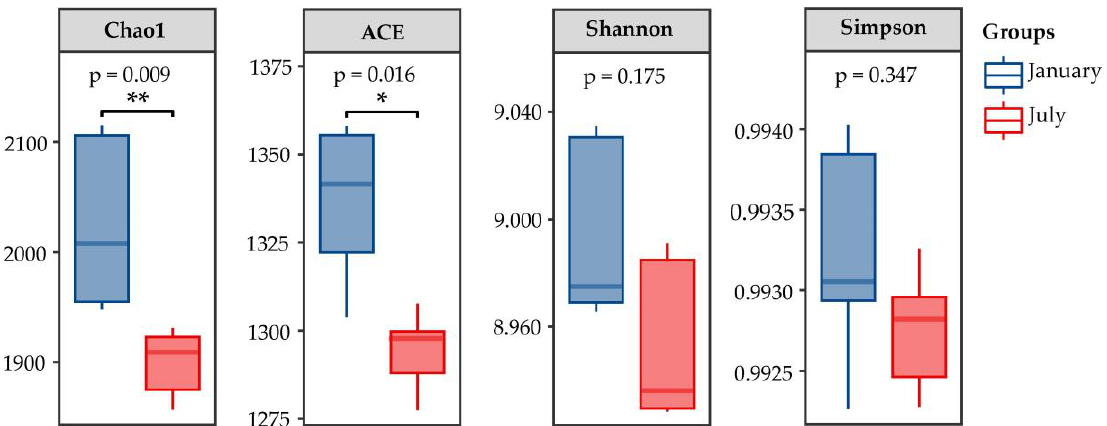
Figure 5. Boxplots of differences in α -diversity indexes for nitrogen-associated microbial communities. * Indicates a significant difference between groups ( p < 0.05). ** Indicates a larger significant difference between groups ( p < 0.01).